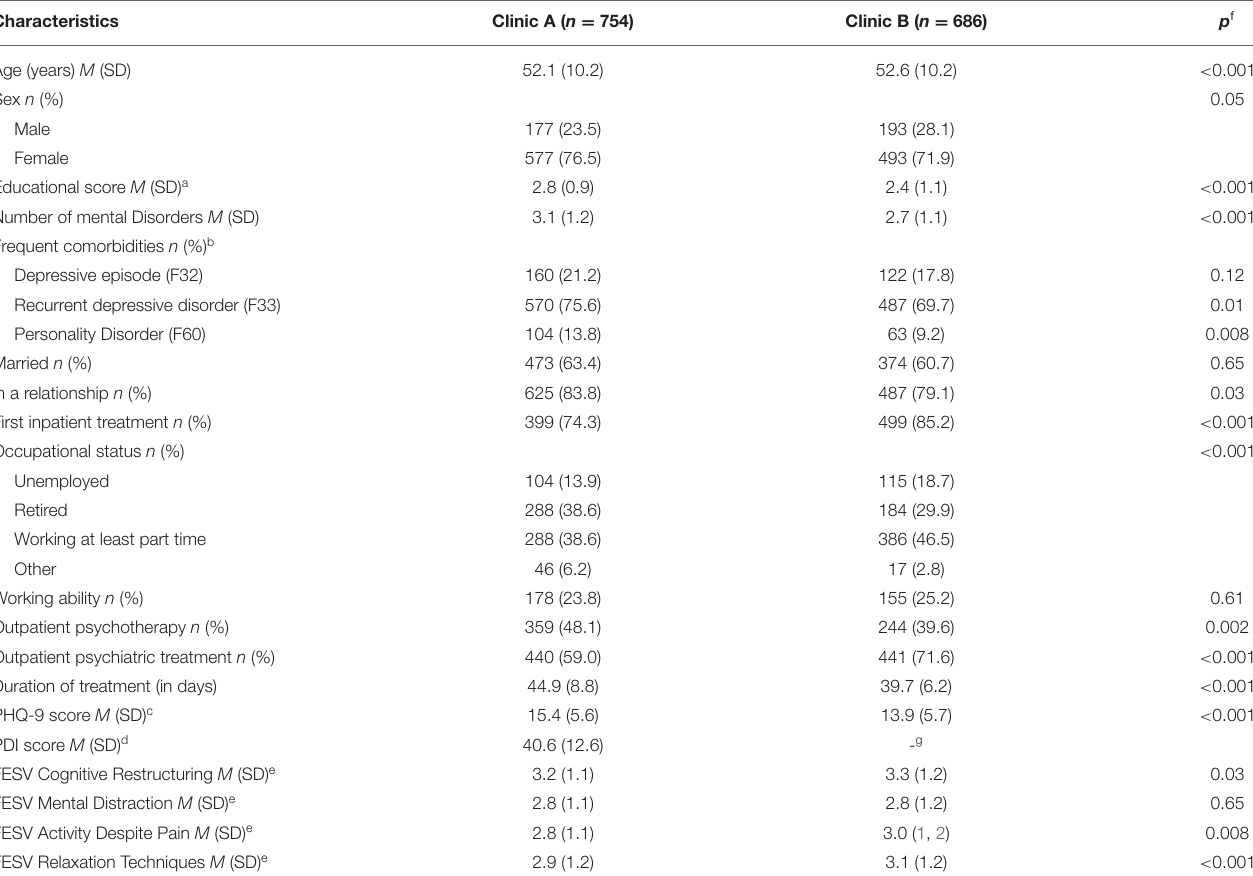
TABLE 2 | Sociodemographic and clinical characteristics as well as self-rating scores of the sample ( n = 754 clinic A and n = 686 clinic B) at baseline.